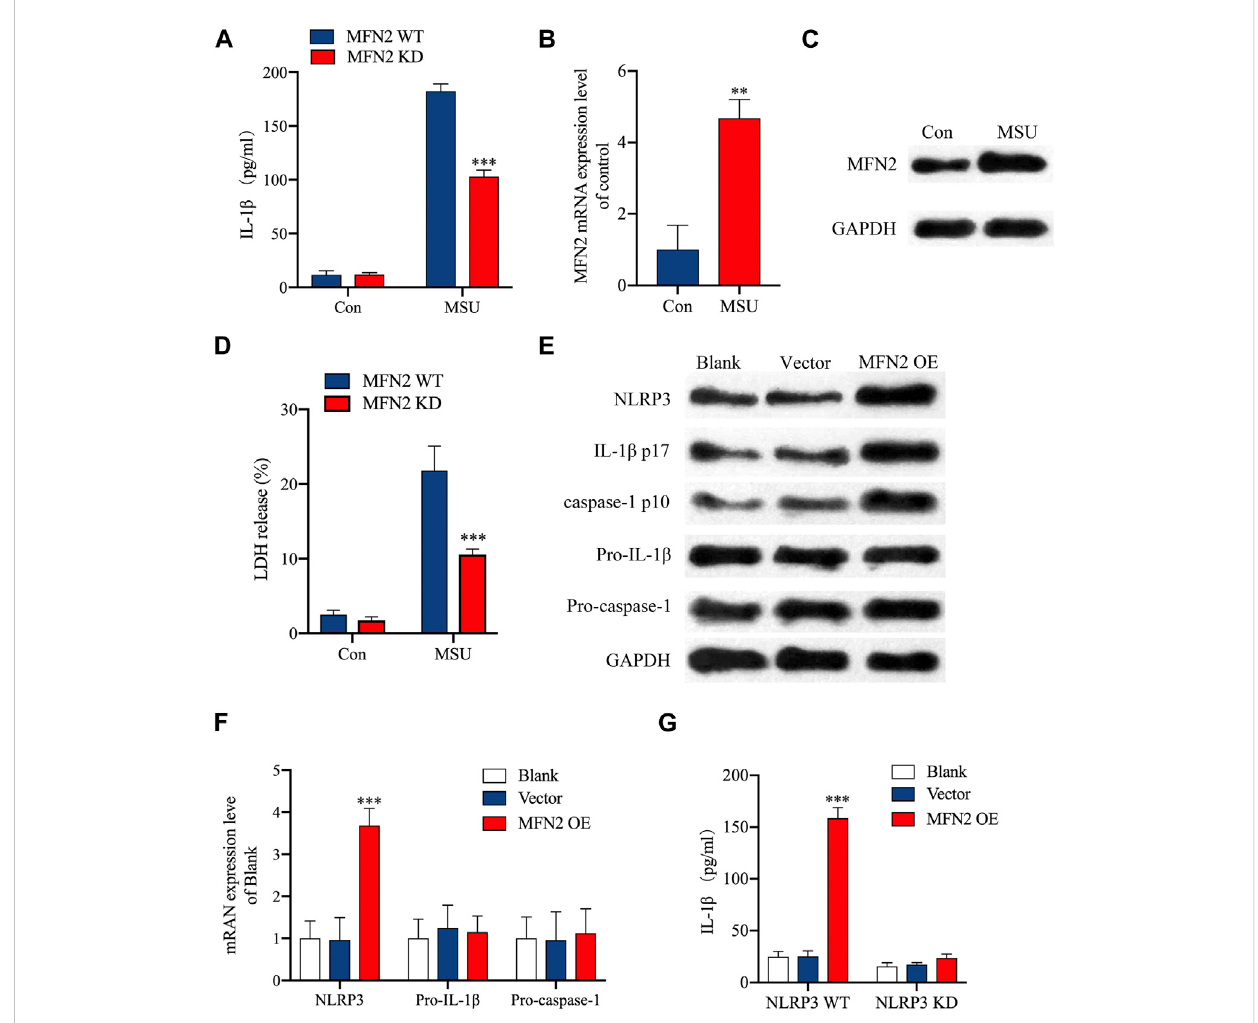
FIGURE 9 Overexpression of MFN2 activated NLRP3 in fl ammasome in NP cells. (A) NP cells were transfected as indicated. IL-1 β released was assessed by ELISA. (B, C) NP cells were stimulated with MSU. MFN2 mRNA expression was assessed by RT-qPCR and Western blot. (D) Pyroptosis was determined by LDH assay. (E) The Western blot assay for NLRP3, IL-1 β cleavage and caspase-1 activation. (F) NP cells were transfected as indicated. NLRP3, pro- IL-1 β and pro-caspase-1 mRNA were assessed by RT-qPCR. (G) NP cells were transfected as indicated. IL-1 β released was assessed by